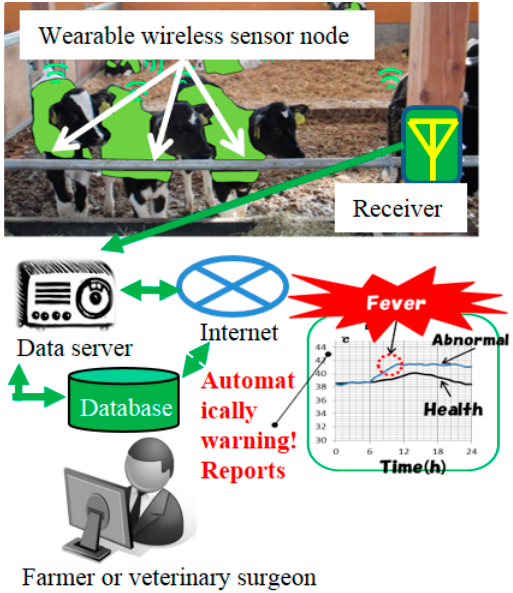
Figure 1. Animal health monitoring system for cows.